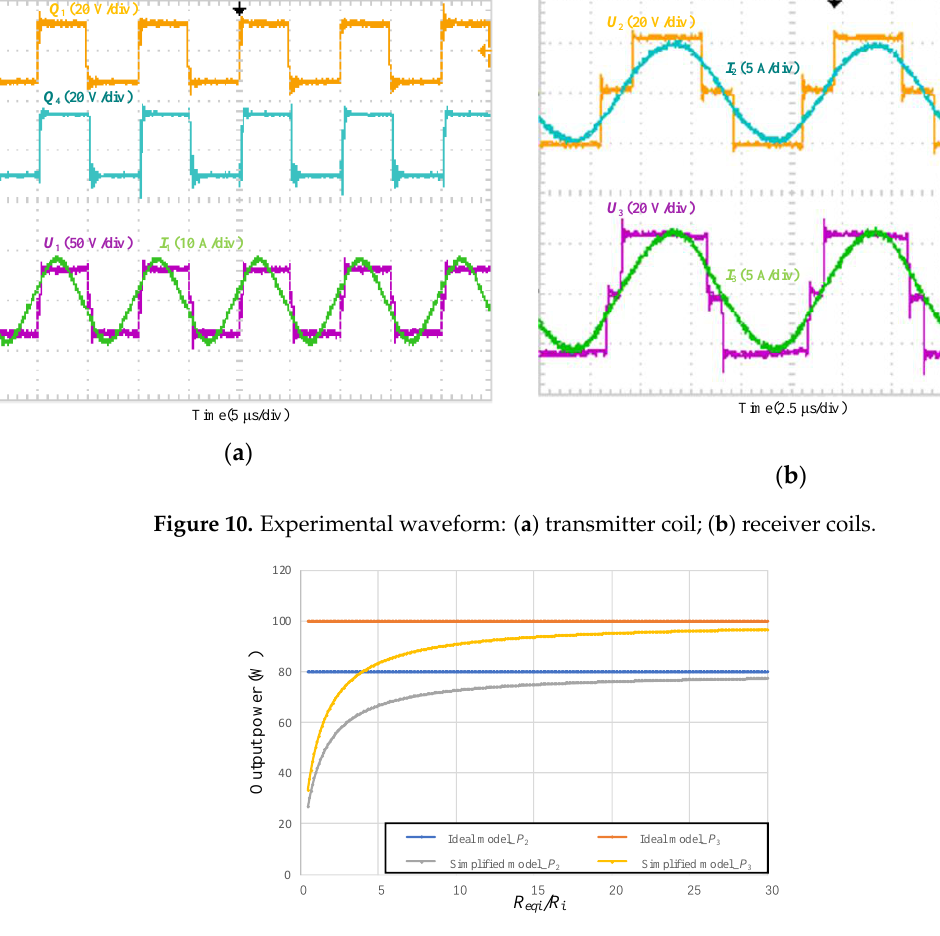
Figure 11. Power of simplified model and ideal model versus resistance ratio ( R eq i / R i ).